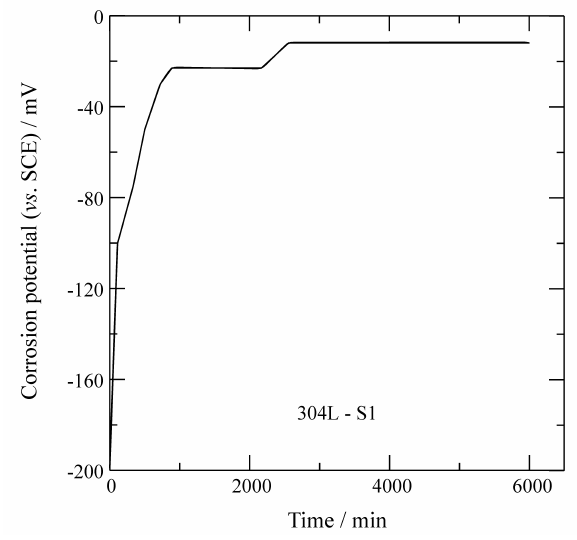
Figure 5. Corrosion potential E corr variation with immersion time in 3.5% NaCl solution for 304L steel with S1 surface finish.